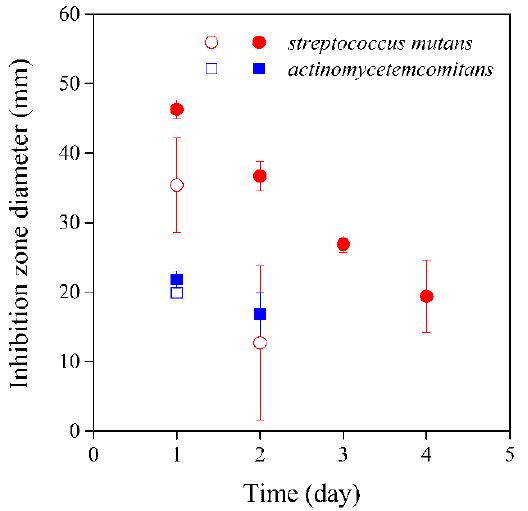
Figure 10. Microbial activity of PLA disks prepared from electrospun fibers with various Amox contents. Symbols: ( ◦ , • ) Streptococcus mutans , ( , (cid:4) ) Aggregatibacter actinomycetemcomitans ; empty contents. Symbols: ( ◯ , ● ) Streptococcus mutans , ( ◻ , ∎ ) Aggregatibacter actinomycetemcomitans ; empty (cid:31) symbols: 0.25 wt%, full symbols: 1.23 wt% symbols: 0.25 wt%, full symbols: 1.23 wt% amoxicillin.